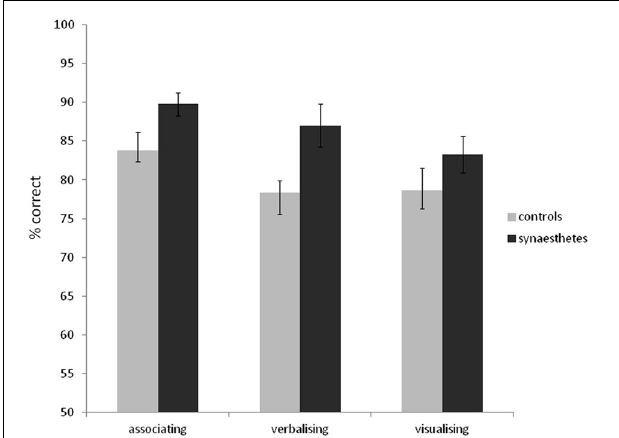
FIGURE 6 | Recognition memory accuracy (% correct) for grapheme-color synaesthetes and controls for words (collapsing data from Experiments 1 and 2), grouping also according to the strategy used. Error bars show ± 1